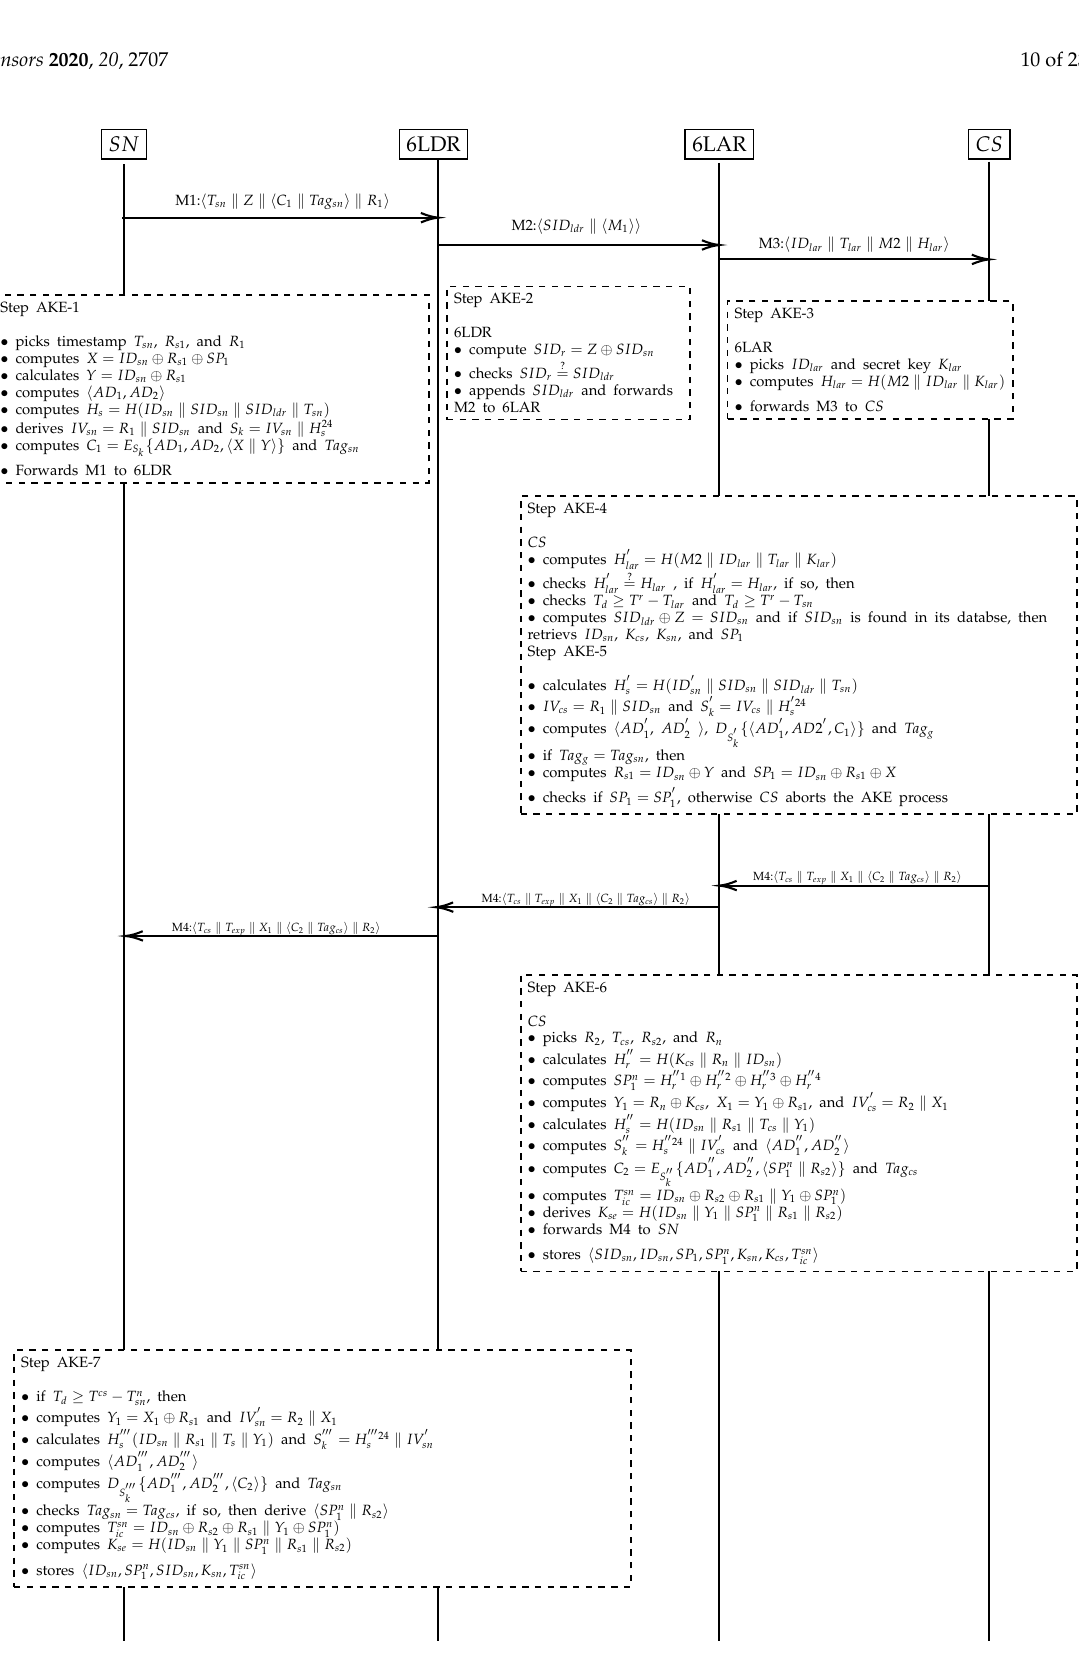
Figure 3. S6AE authentication and key establishment